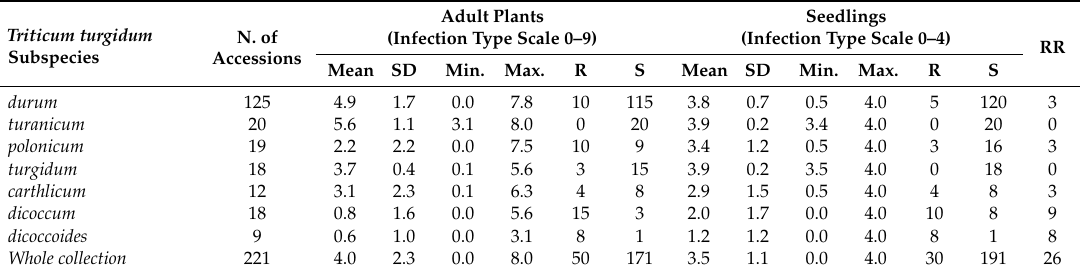
Table 1. Summary of phenotypic data of 221 tetraploid wheat accessions evaluated for their reaction to Blumeria graminis f. sp. tritici at adult plant and seedling stages. All lines were classified into two groups with resistant lines (R) scoring 0–2 at seedlings and adult plants, and susceptible lines (S) scoring 2.1–4.0 for seedlings and 2.1–9.0 for adult plants. SD = standard deviation. RR = Resistant accessions at seedling and adult plant